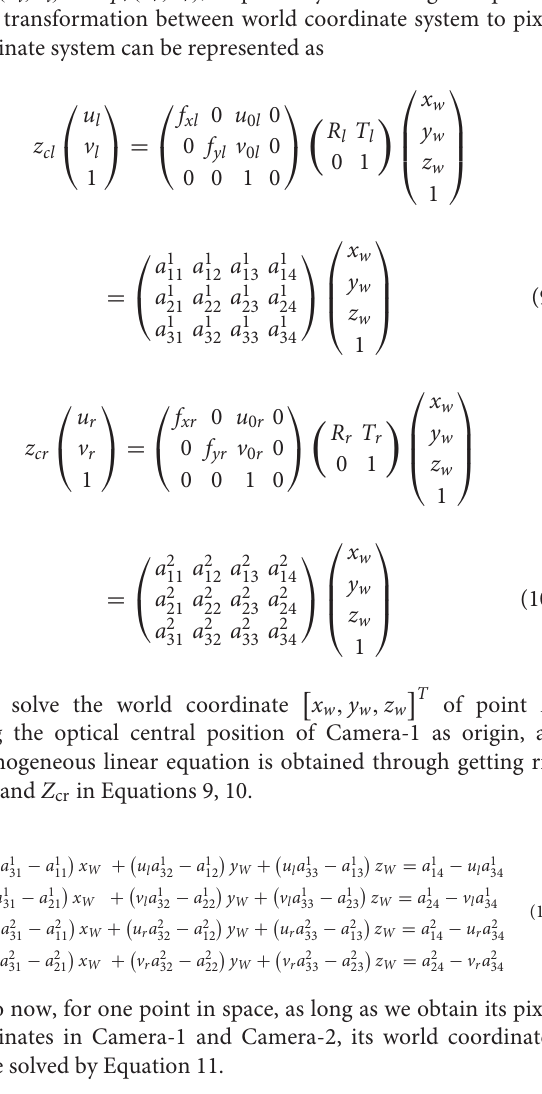
Figure 7A is the 2G-R-B gray image of Image-2. The bilateral filtering for image denoising is used for image noise removal.